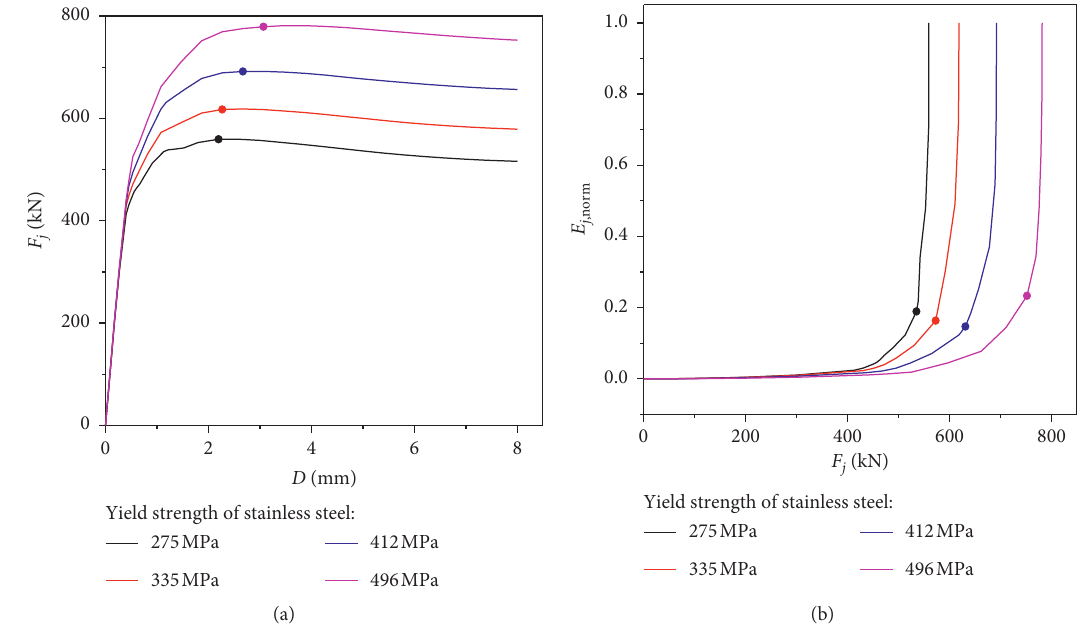
Figure 11: (a) F − D curves of different yield strength of stainless steel. (b) E j